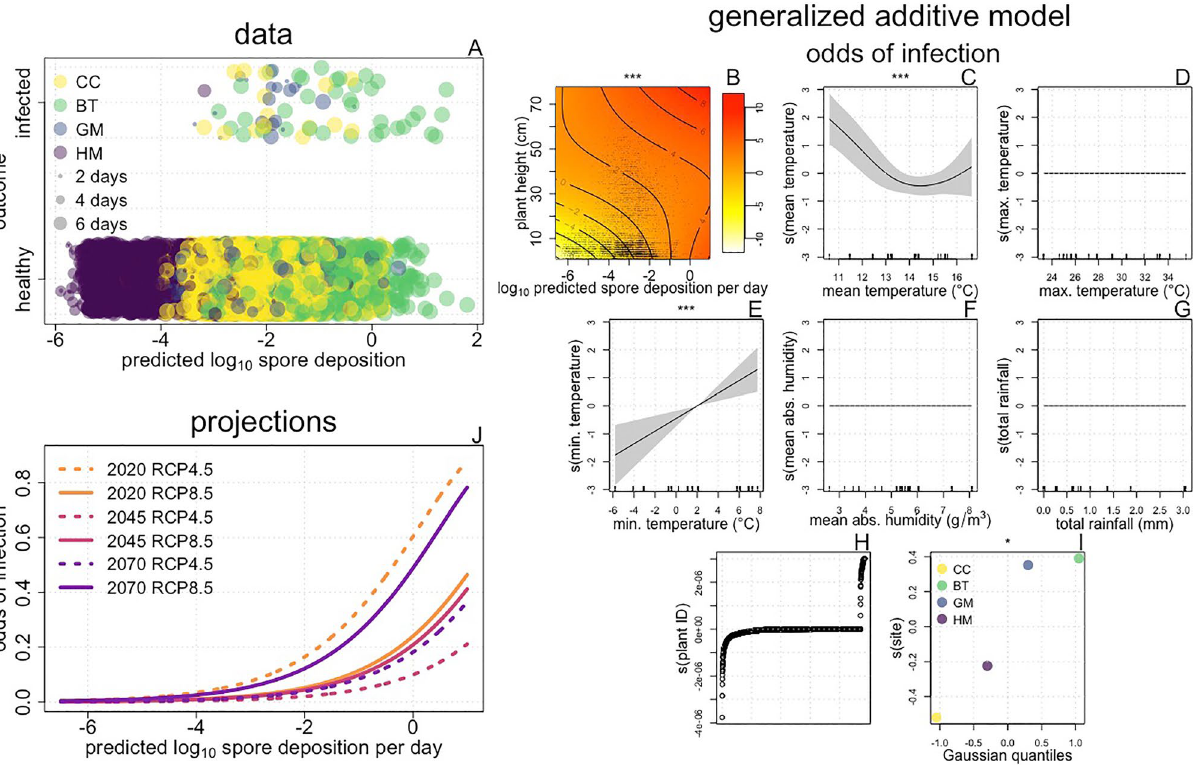
Figure 5. The effects of climate and spore deposition on infection risk. Data: We predicted the total spore deposition experience by each uninfected plant at each study site over the periods between observations of infection status. We made these 9142 predictions using the TGPM in conjunction with observed wind speed, the locations of infected plants, and the infection intensities and heights of those plants. Points in panel ( A ) show infection outcome vs log 10 predicted spore deposition, with the color and size of the points representing study site and the time between observations. Generalized additive model: We fit a GAM to this data using infection outcome as the response variable and assuming a binomial response distribution. We used a complementary log–log link function and included an offset of log time to account for variation in the length of the observation period. Predictors included smooth terms for weather variables, random effect smooths for plant identity and site, and a full tensor product of log 10 predicted spore deposition per day and plant height. Panel ( B ) shows the fitted tensor, with contours, shading, and points as in Fig. 3B. Panels ( C – G ) show fitted smooth terms with axes, lines, and shading as in Fig. 2B–G. Panel ( H ) shows fitted random effects for plant identity plotted in the order of their magnitude. Panel ( I ) shows fitted random effects for site with points and axes as in Fig. 2I. Symbols above plots show the significance of smooth terms, with *** indicating p < 0.001, ** indicating p < 0.01, and * indicating p < 0.05. Projections: Lines in panel ( J ) show the relationship between log 10 predicted spore deposition per day and the odds of infection (for a plant with a height of 25 cm at the GM site) projected from the fitted GAM for the time period spanning July 7th–July14th. We replicated these predictions across weather data sets projected for six climate